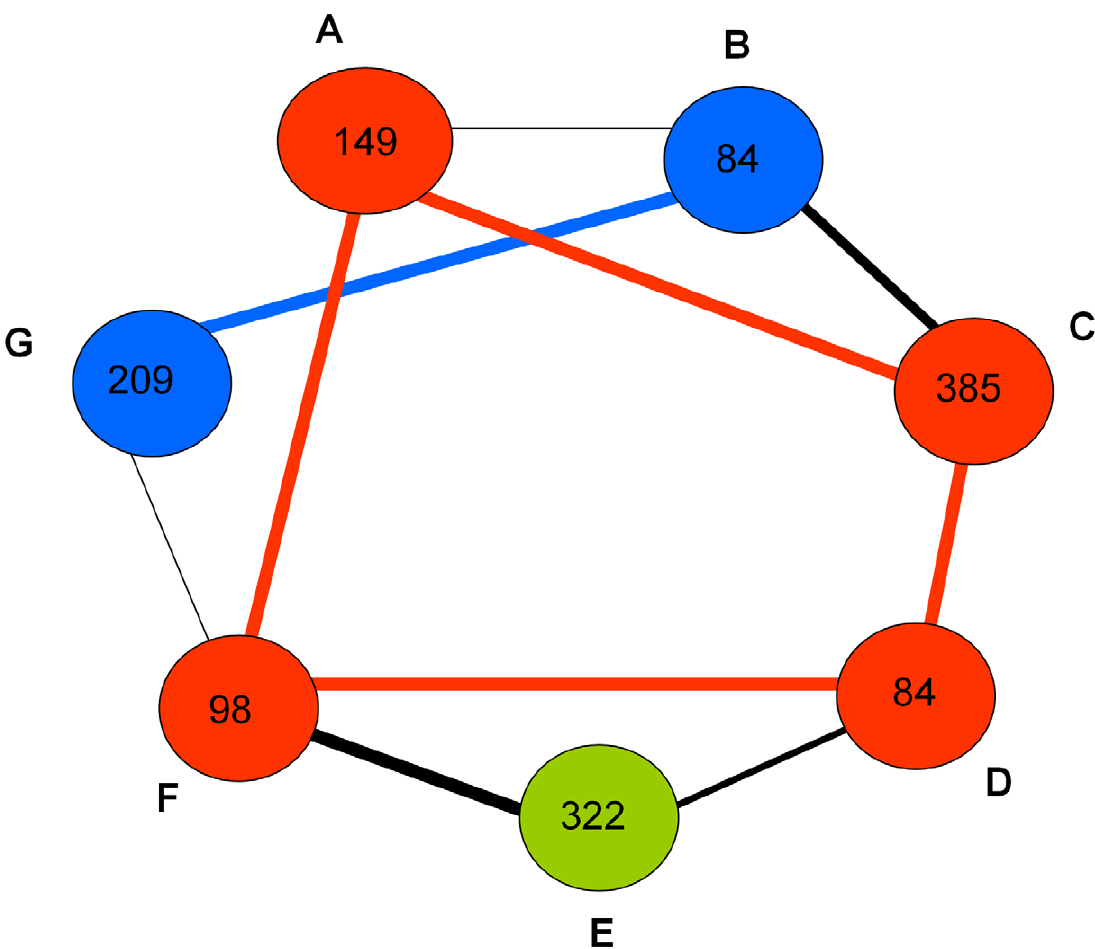
Figure 3. A simplified illustration of inter-modular networking of Aedesaegypti genes responsive genes. The expression modules are shown by colored circles (A through G). The number of genes belonging to each module is shown. The black lines connect the modules. The thickness of these line shows how closely similar they are to each other in the cluster tree (see Figure 1). The red colored circles and lines represent the refractory response modules (RRM), the green color circle represents the susceptible response module (SRM) and the blue colored circles and lines represent the core response modules (CRM).